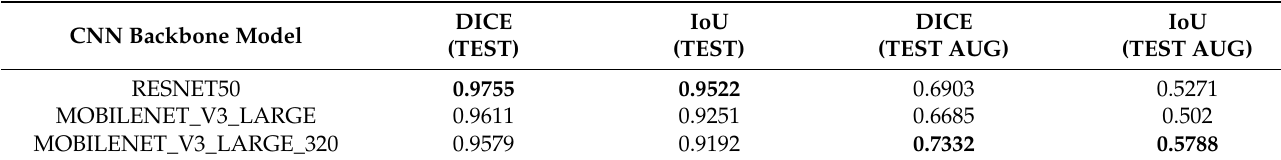
Table 5. Faster R-CNN backbone models’ DICE and IoU scores on TEST and TEST AUG set. Proba- bility threshold 0.95 (95%). Best results are bold.